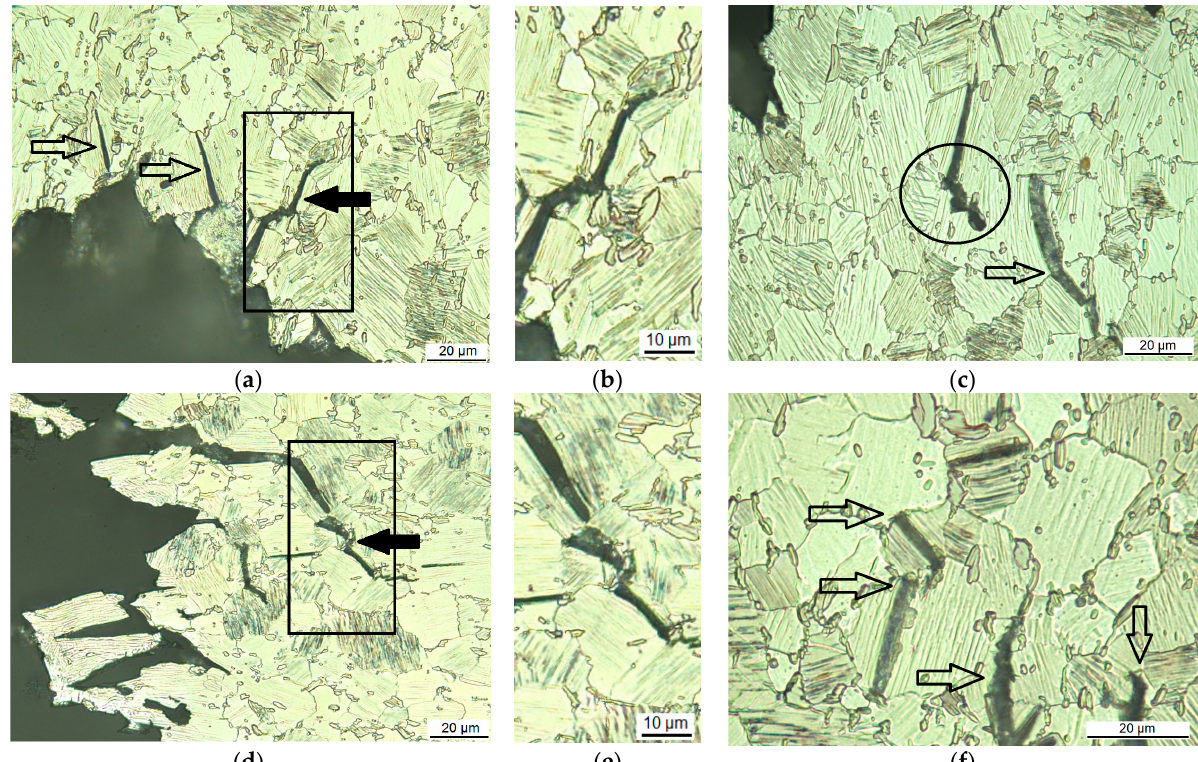
Figure 3. Cross ‐ sectional optical micrographs of the crack path in the Mg ‐ Dy ‐ Nd ‐ Zn ‐ Zr alloy C ‐ ring samples for the fine ‐ Figure 3. Cross-sectional optical micrographs of the crack path in the Mg-Dy-Nd-Zn-Zr alloy C-ring samples for the grained microstructure: extruded ( a – c ) and heat ‐ treated at 200 °C for 4 h ( d – f ). fine-grained microstructure: extruded ( a – c ) and heat-treated at 200 ◦ C for 4 h ( d – f